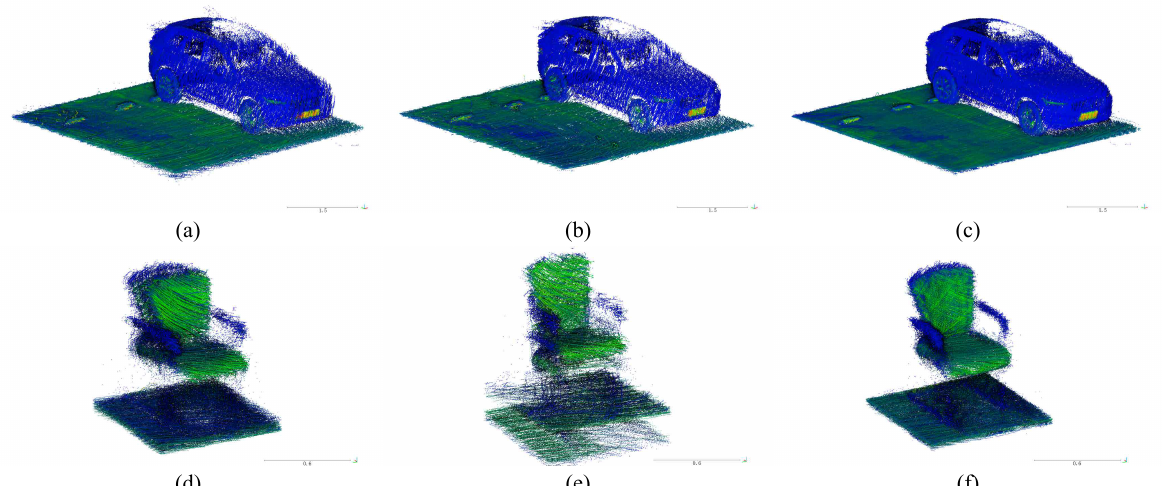
Figure 7. The comparison of point cloud details. (a) the car generated by LOAM; (b) the car generated by LIOM; (c) the car generated by Ours; (d) the chair generated by LOAM; (e) the chair generated by LIOM; (f) the chair generated by